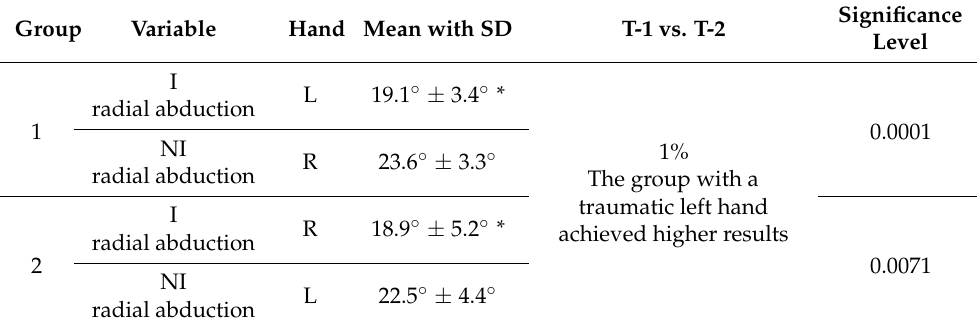
Table 4. Comparison of results for radial abduction.